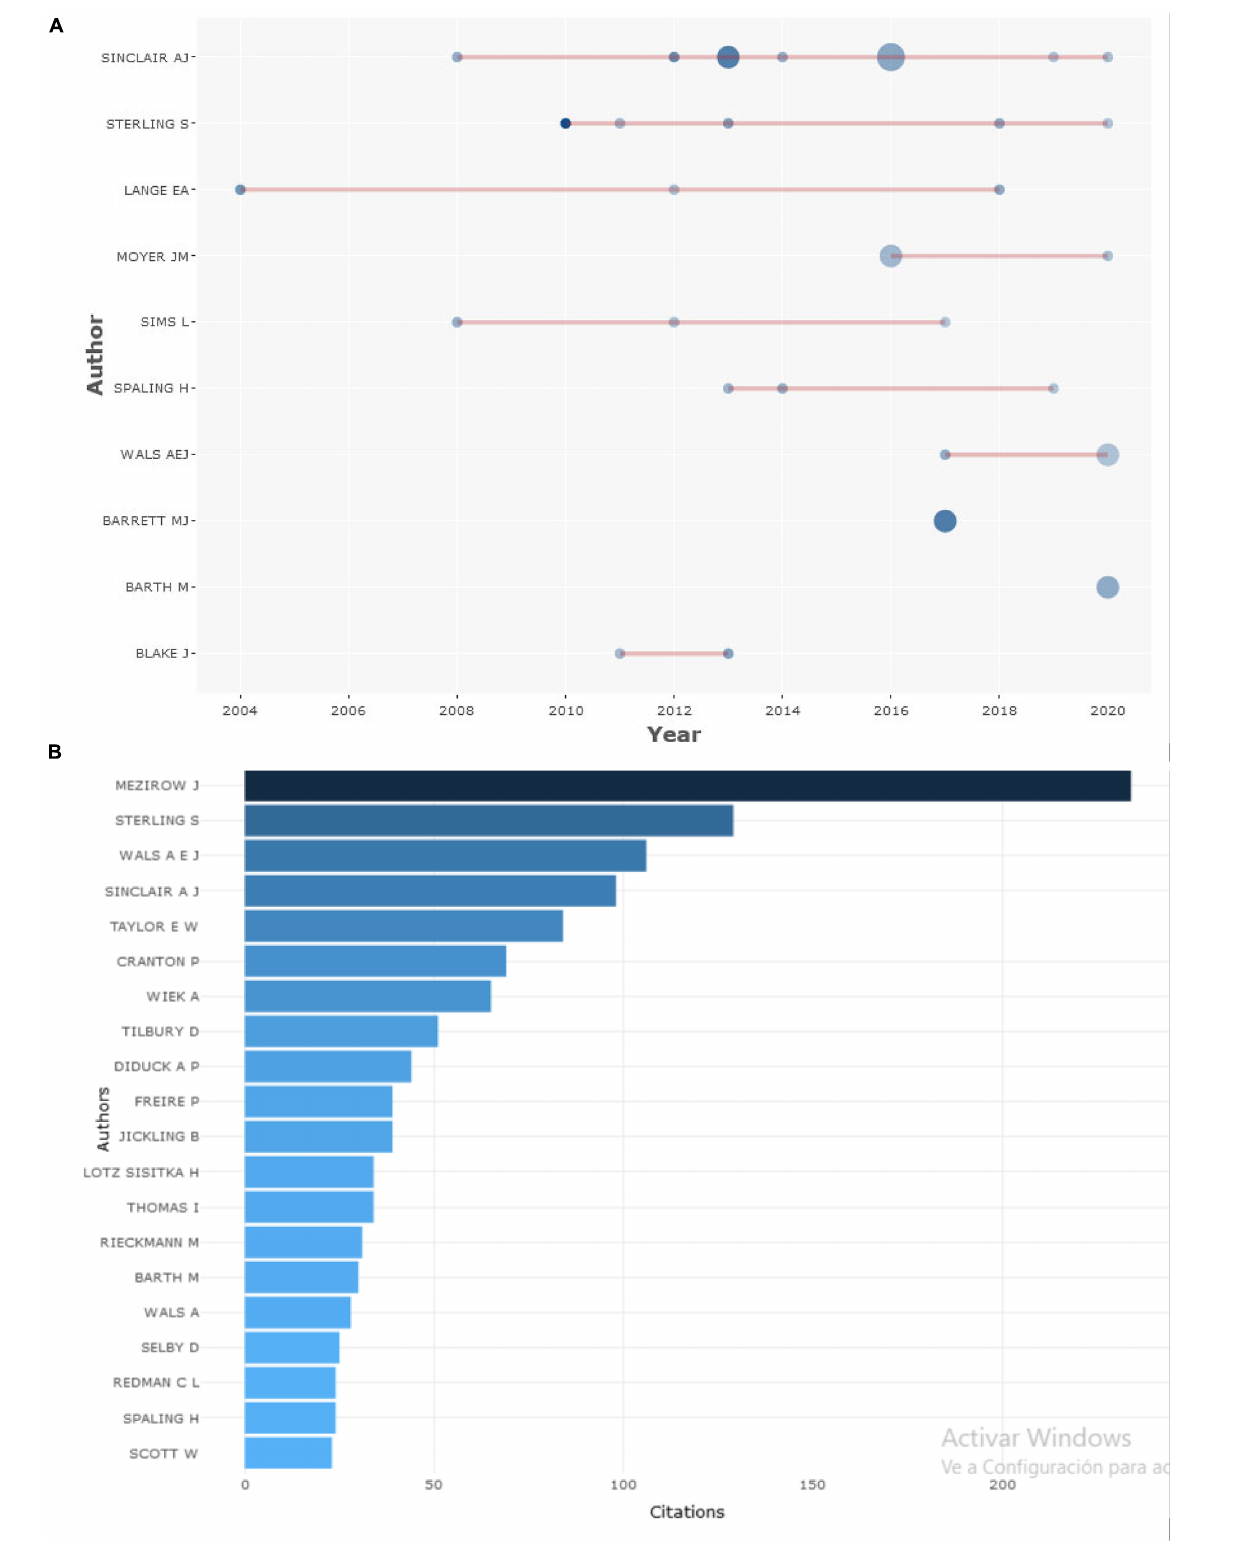
Frontiers in Education |